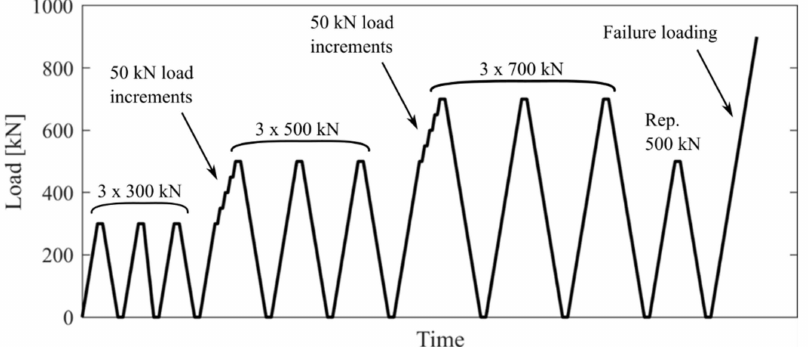
Figure 9. Loading scheme. Three load segments to 300 kN (before detectable cracking), three load segments to 500 kN (after crack detection), three load segments to 700 kN (developed cracks and plastic deformation), one load segment to 500 kN before loading to